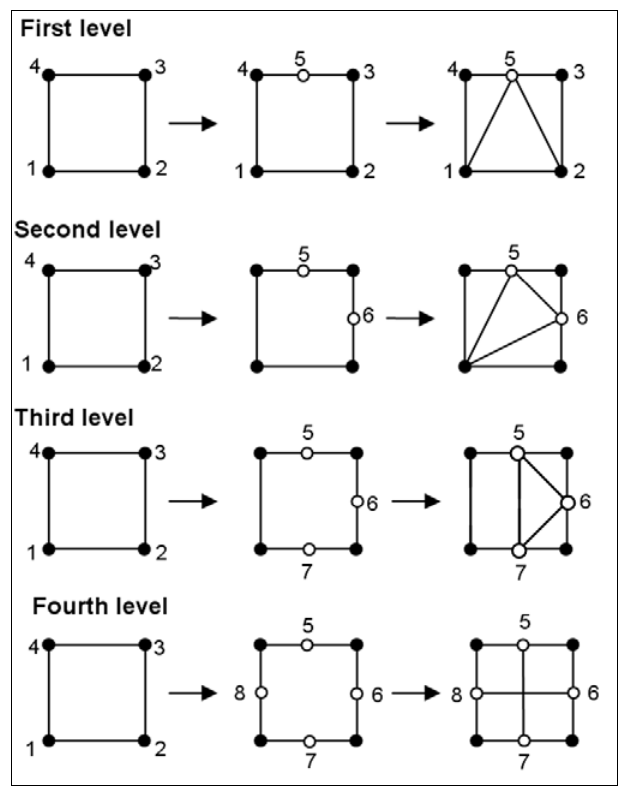
Figure 4. Different levels of fabric remeshing